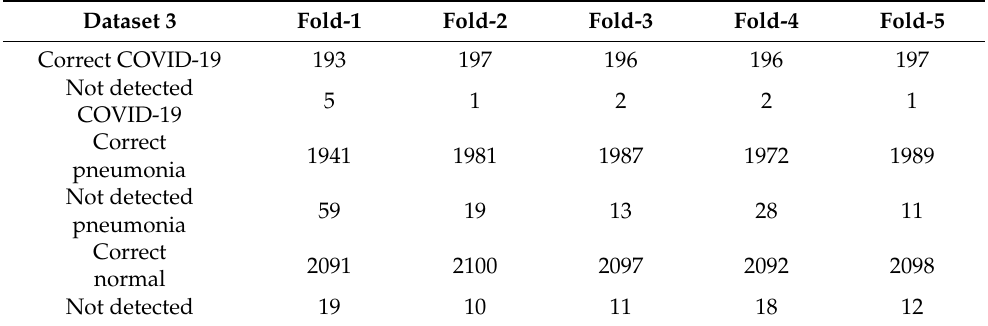
Table 11. Detailed dataset 3 results.